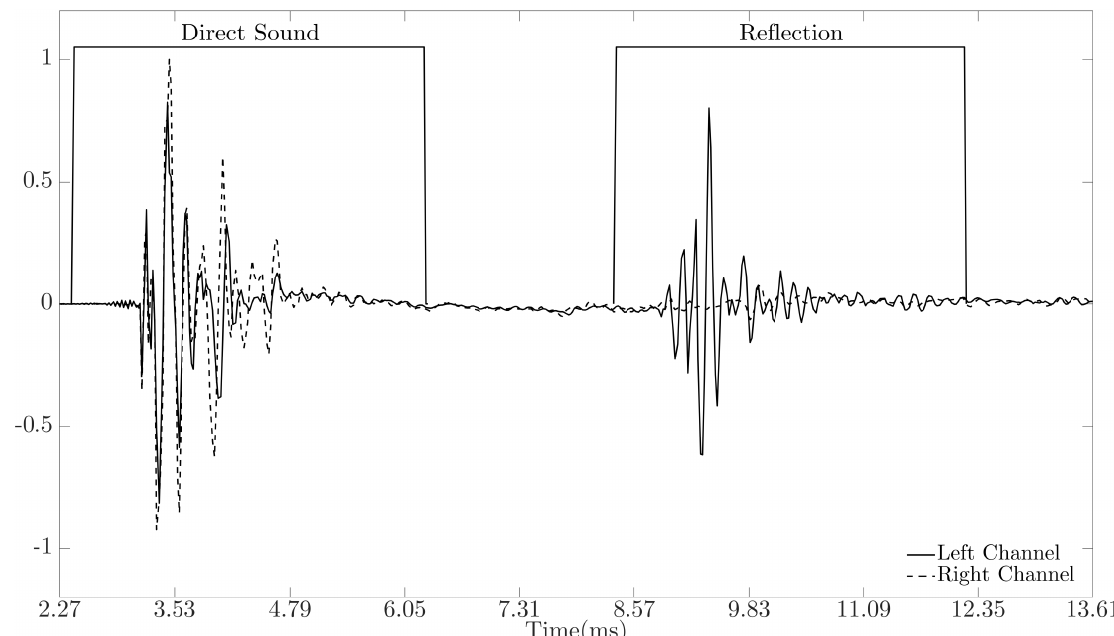
Figure 5. Example binaural room impulse response generated with source at azimuth = 0 ◦ and reflector at azimuth = 71 ◦ ; the solid line is the left channel of the impulse response; the dotted line is the right channel of the impulse response; and the windowed area denotes the segmented regions using the technique discussed in Section